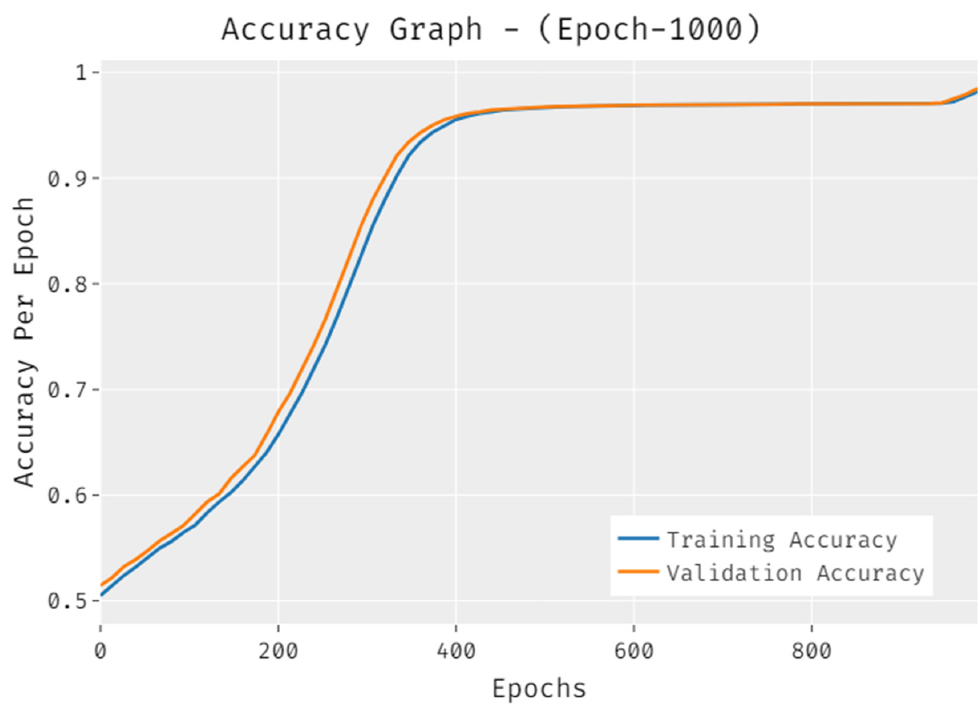
Figure 11. Accuracy graph analysis of DLSODC ‐ GWM technique under 1000 epochs.